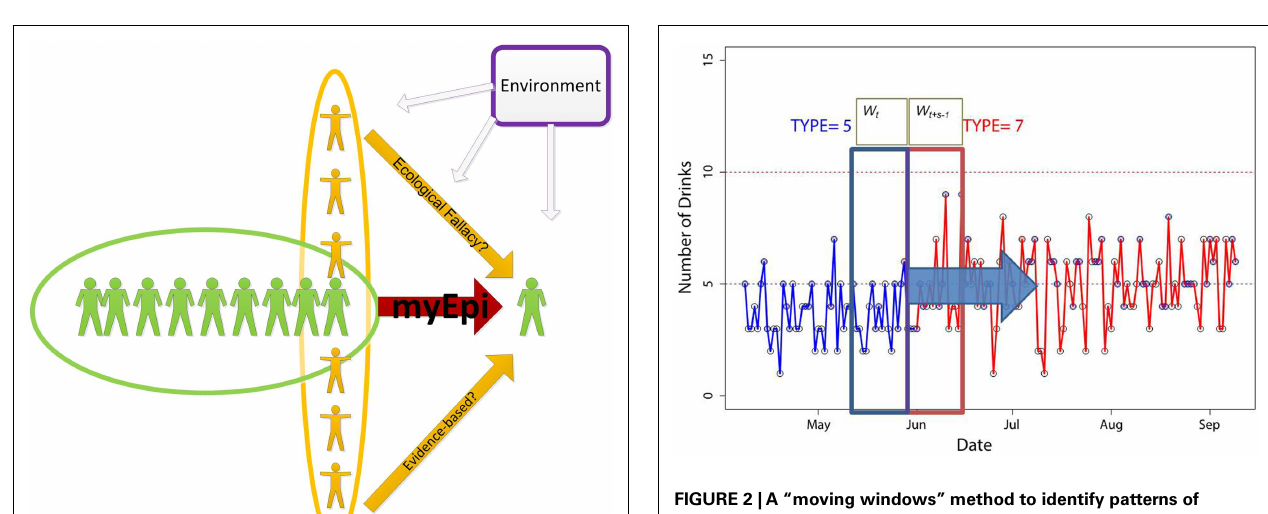
FIGURE 2 |A “moving windows” method to identify patterns of alcohol use trajectories . Distributional properties of sliding windows W t and W t + s − 1 are compared to each other.The point when the distributions become significantly different signifies the change in patterns.We illustrate the point at which the pattern switched from type 5 to 7 as the number of drinks increases.The figure is reproduced with permission from Ref.